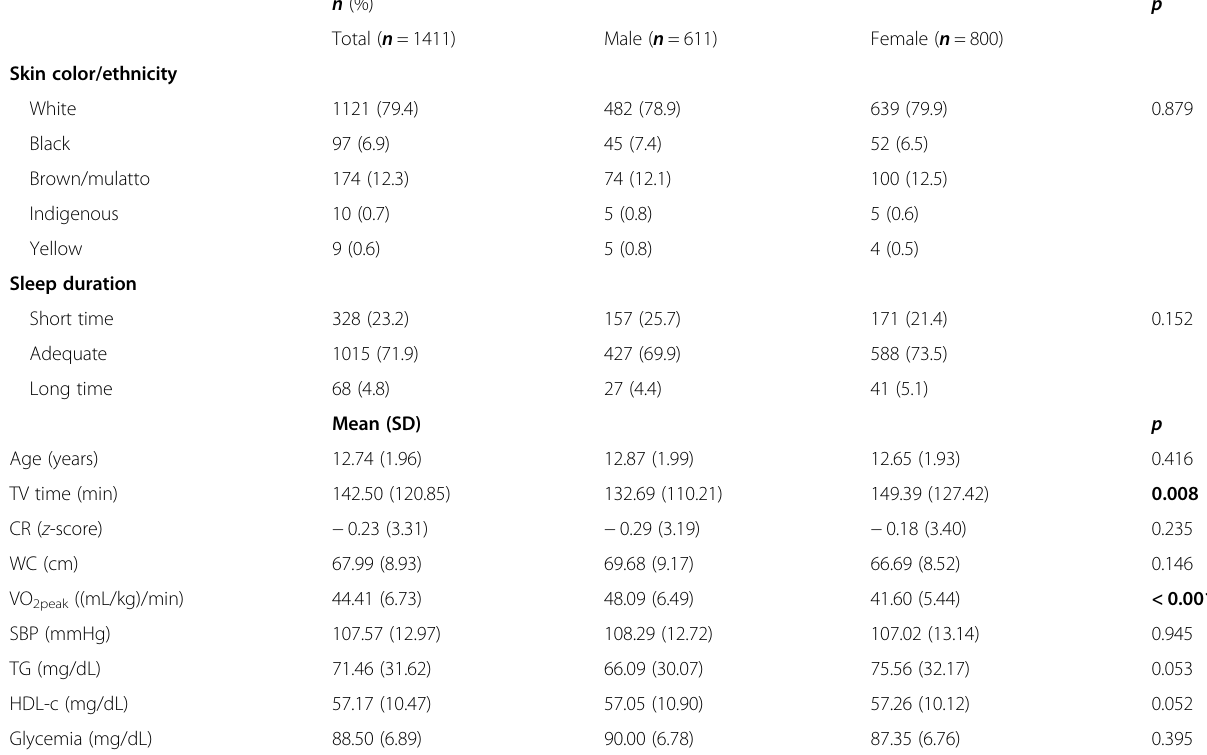
Table 1 Descriptive characteristics of adolescents according to